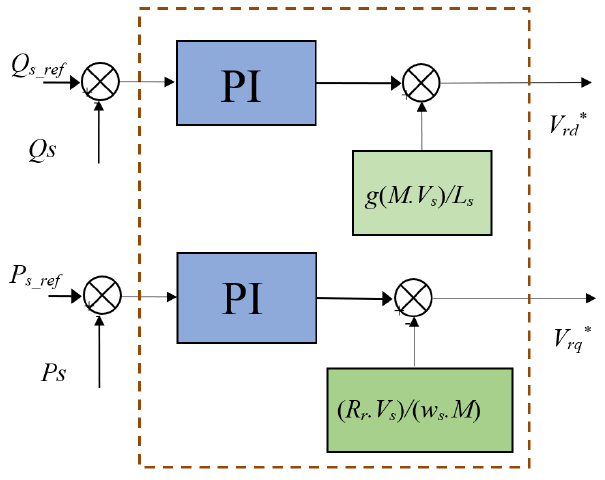
Figure 3. Classical direct FOC technique.